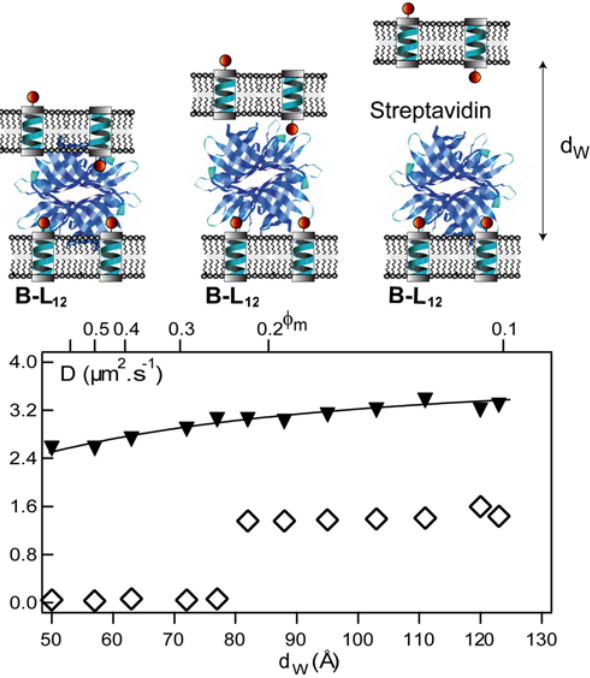
Figure 2. Evolution of the diffusion coefficient of bound streptavidin with the distance between bilayers. The top sketch represents a FITC-labeled streptavidin that is bound to two biotinylated peptides for large d W values, and that bridges peptides from two different bilayers when d W , 80 A˚ as seen below for (empty diamonds). The bottom graph displays the diffusion coefficients, D , versus the separation distance between bilayers, d W . (black triangles down) represents the diffusion coefficient, D L12 , of FITC-labeled L 12 peptides embedded in the bilayers of the L 3 phase devoid of streptavidin. This result is well described by the equation 1 (black solid line) as predicted for a surface diffusing object. (empty diamonds) are for FITC-labeled streptavidin proteins inserted in the sponge phase in the presence of biotinylated peptides, B-L 12 , at the molar ratio [B-L 12 ]/[S]=10. For d W . 80 A˚, streptavidins bind biotinylated peptides embedded in the same bilayers and for d W , 80 A˚, streptavidins bind biotinylated peptides embedded from opposite bilayers. Error bars are smaller than symbol size. The membrane volume fraction w m corresponding to each size is indicated at the top of the graph.